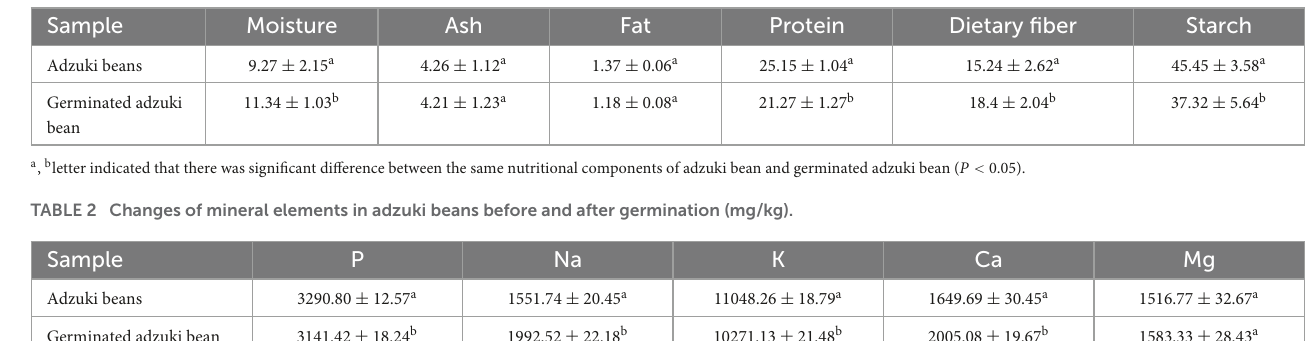
TABLE 1 Changes of main components of adzuki beans before and after germination (g/100 g). Sample